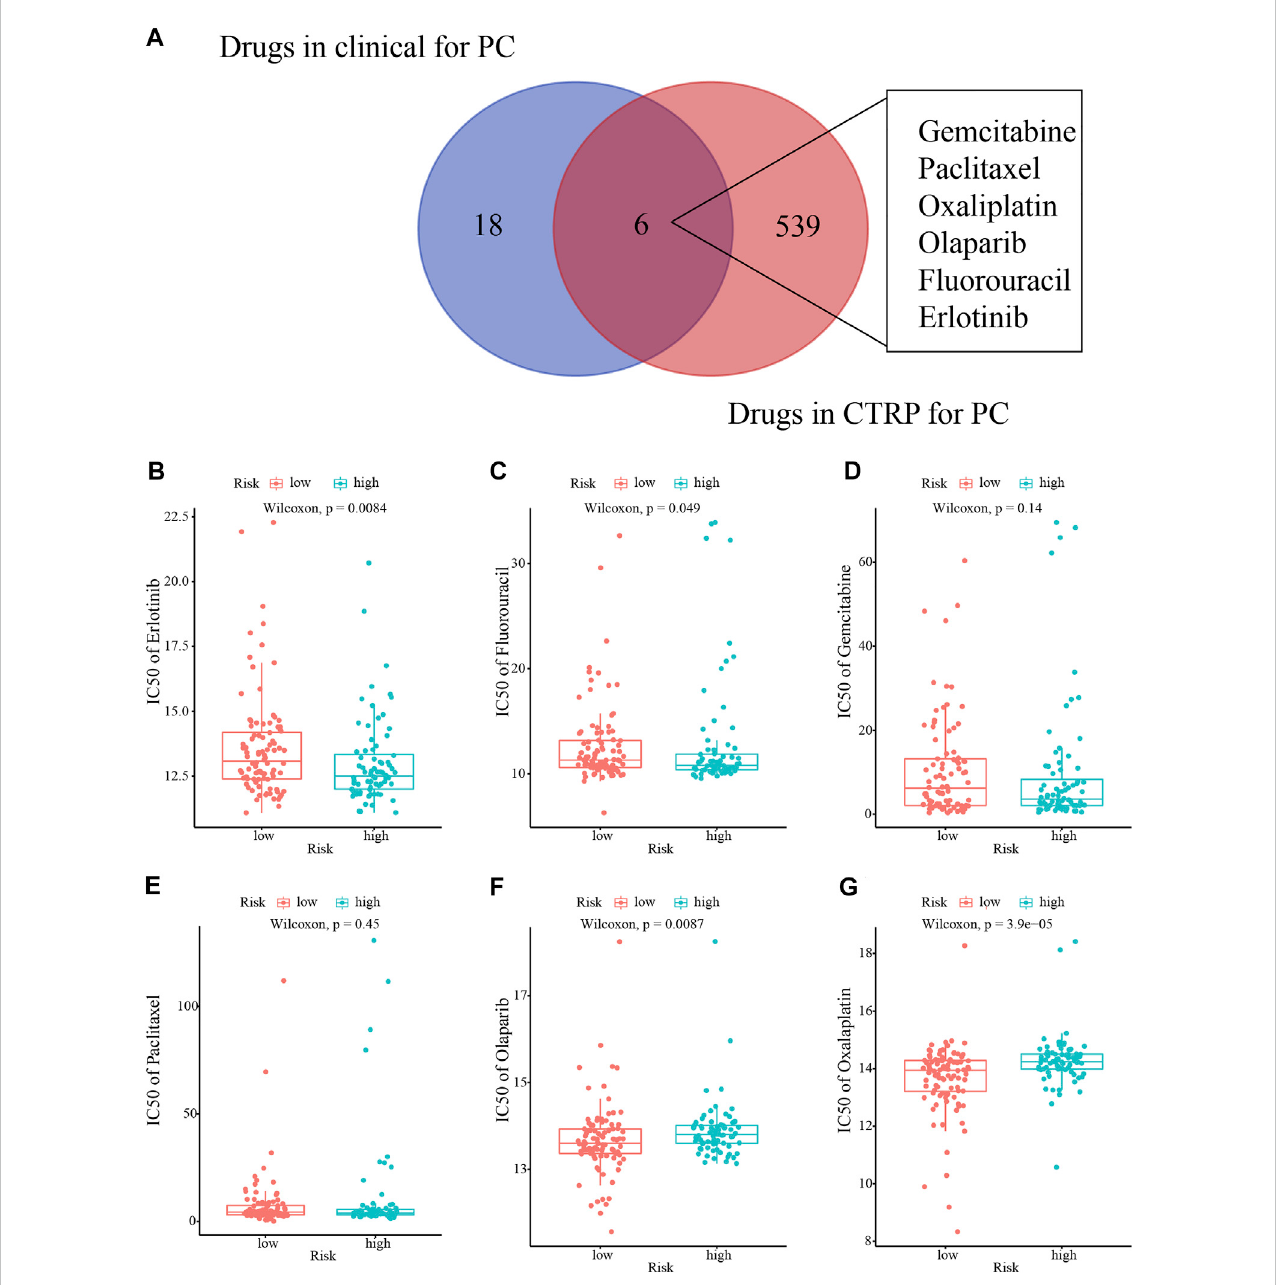
FIGURE 10 Drug sensitivity analysis. (A) Venn diagram of the clinical use of the drugs for PC. (B – G) The sensitivity to six drugs (Erlotinib, Fluorouracil, Gemcitabine, Paclitaxel, Olaparib, and Oxaliplatin) in different risk